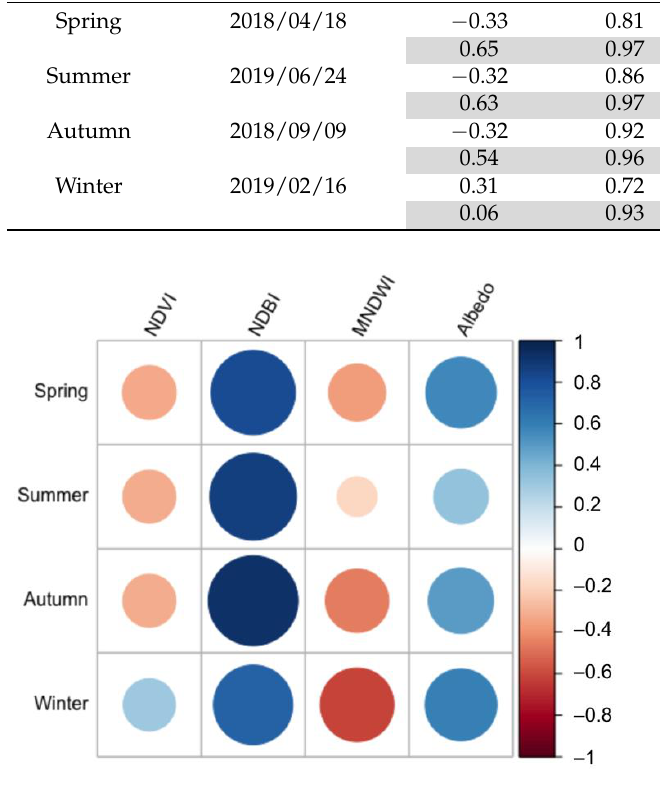
Figure 10. Plot of the correlation coefficient of four land cover indices in daytime.